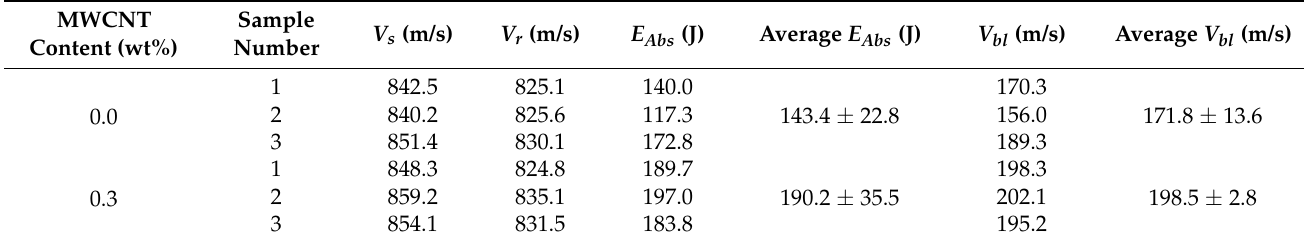
Table 2. Impact velocity, residual velocity, energy absorption and ballistic limit velocity values determined for aramid fabrics that were reinforced with poly(BA-a/PU) composites containing various quantities of